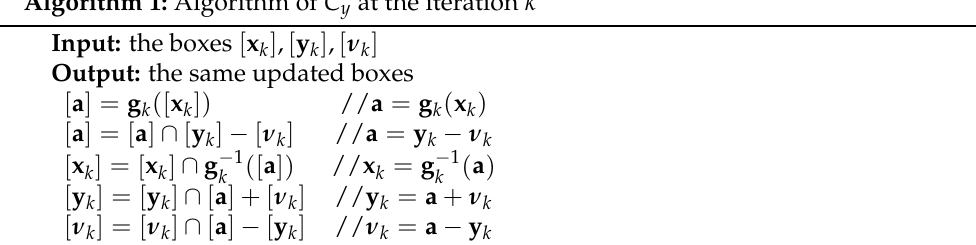
Algorithm 1: Algorithm of C y at the iteration